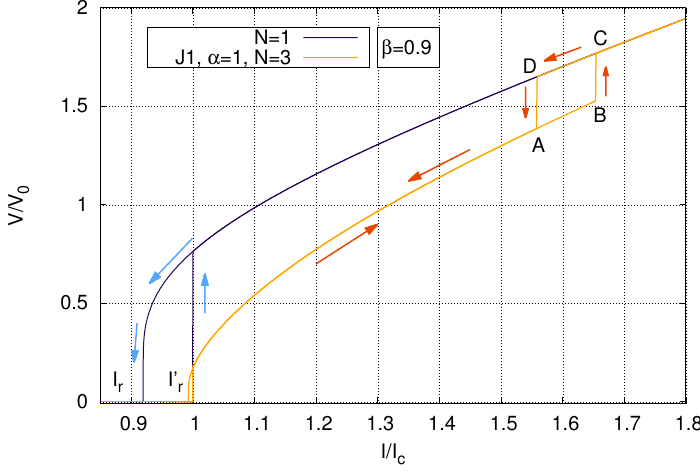
Figure 1. IV-characteristics for a junction for β = 0.9 with the return current I r is shown with a dark blue line and for the first junction in the stack of 3 junctions for β = 0.9 and α = 1 with the return current I (cid:48) r , shown with an orange line. The directions of current are shown with arrows next to the IV-characteristics. Simulations have been done for periodic boundary